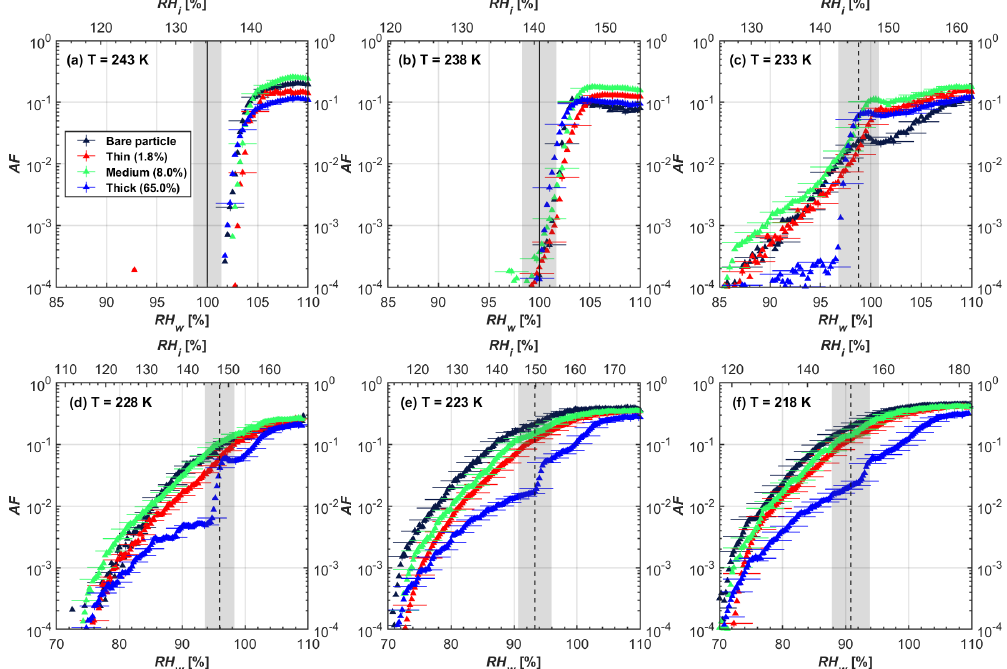
Figure 7. AF as a function of RH at the given temperatures for 400nm FW200 soot particles. Black solid lines represent water saturation conditions according to Murphy and Koop (2005). Black dashed lines denote the expected RH values for solution droplet homogeneous freezing at T < HNT (Koop et al., 2000). The grey-shaded area shows the possible RH variation and uncertainty in HINC for the calculated water saturation and homogeneous freezing conditions. The percentages represent the H 2 SO 4